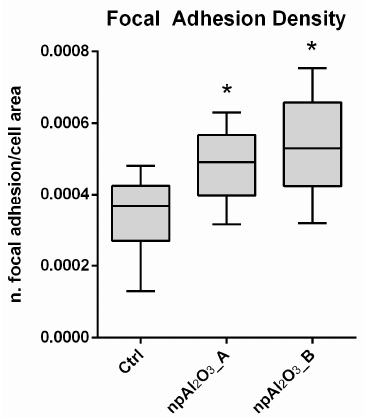
Figure 6. Focal adhesions density evaluation. Focal adhesions density was measured for MC3T3-E1 as the number of focal adhesions/cell area after 24 h from seeding on different samples. The symbol (*) indicates a statistically significant difference versus the control (Ctrl), considering a p -value < 0.05.